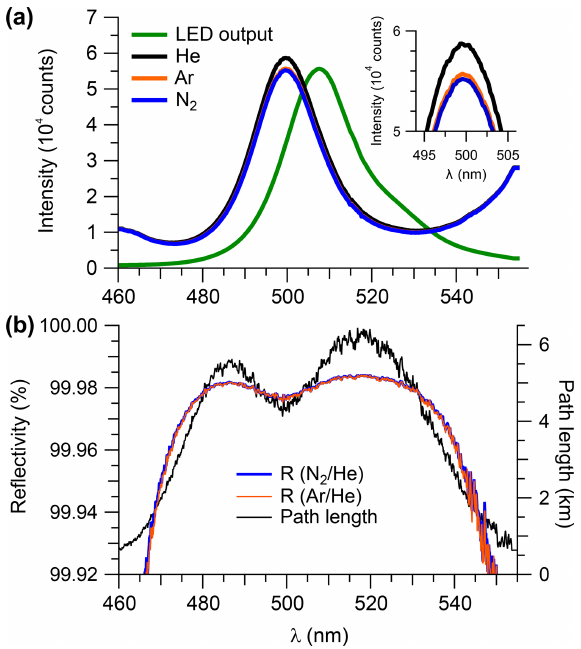
Figure 3. (a) Transmission spectra (averaged over 15min) observed when the sample cell was filled with He, Ar, or N 2 at ambient pressure (890hPa). The LED output spectrum (in arbitrarily scaled units) is superimposed. (b) Mirror reflectivity and effective path length (based on Ar / He) calculated from the data shown in panel (a)